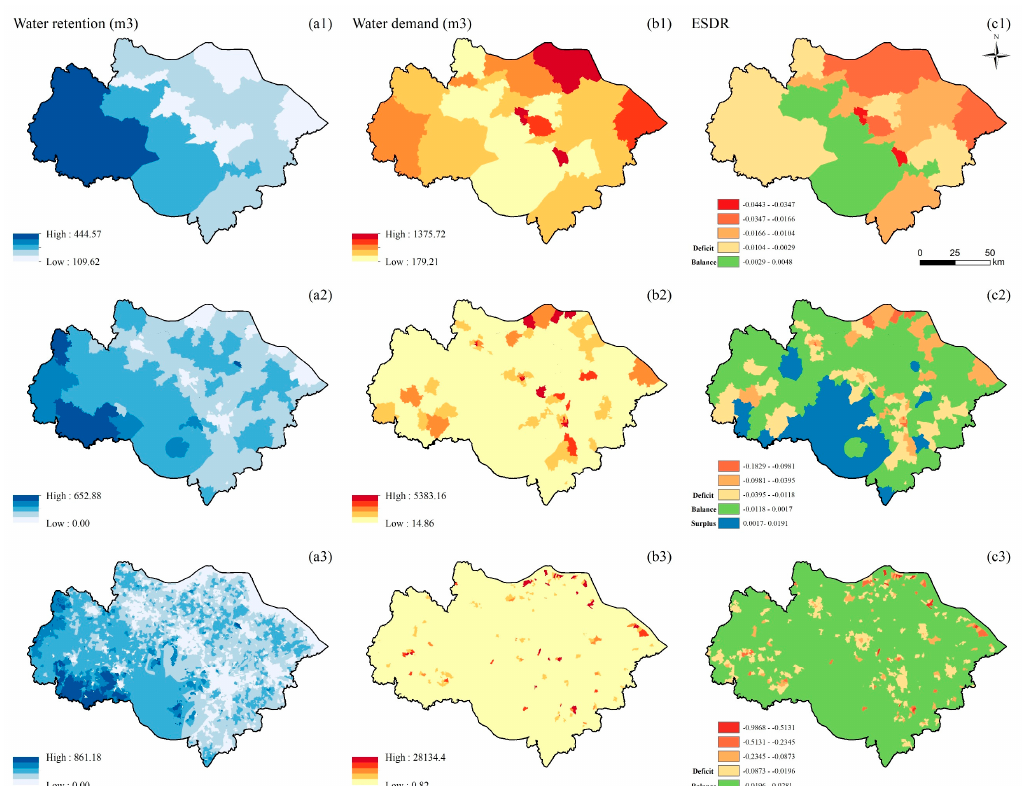
Figure 3. Spatial distribution of WR (unit: m 3 /900 m 2 ) at the county ( a1 , b1 , c1 ), township ( a2 , b2 , c2 ), and village ( a3 , b3 , c3 ) scales; supply of WR ( a1 – a3 ); demand for WR ( b1 – b3 ); ESDR ( c1 – c3 ).